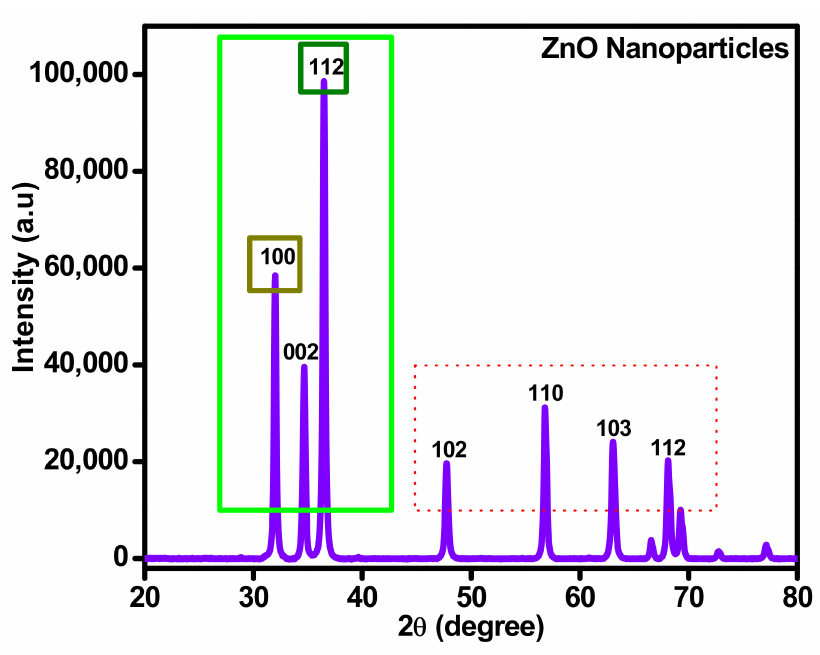
Figure 6. XRD spectrum analysis for sonochemically synthesized ZnO.